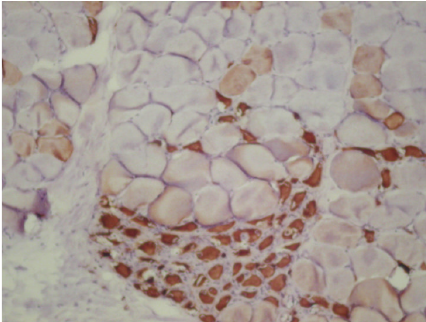
Figure 1: Differences in the size and shape of myofibers as well as regeneration (HEx 200).